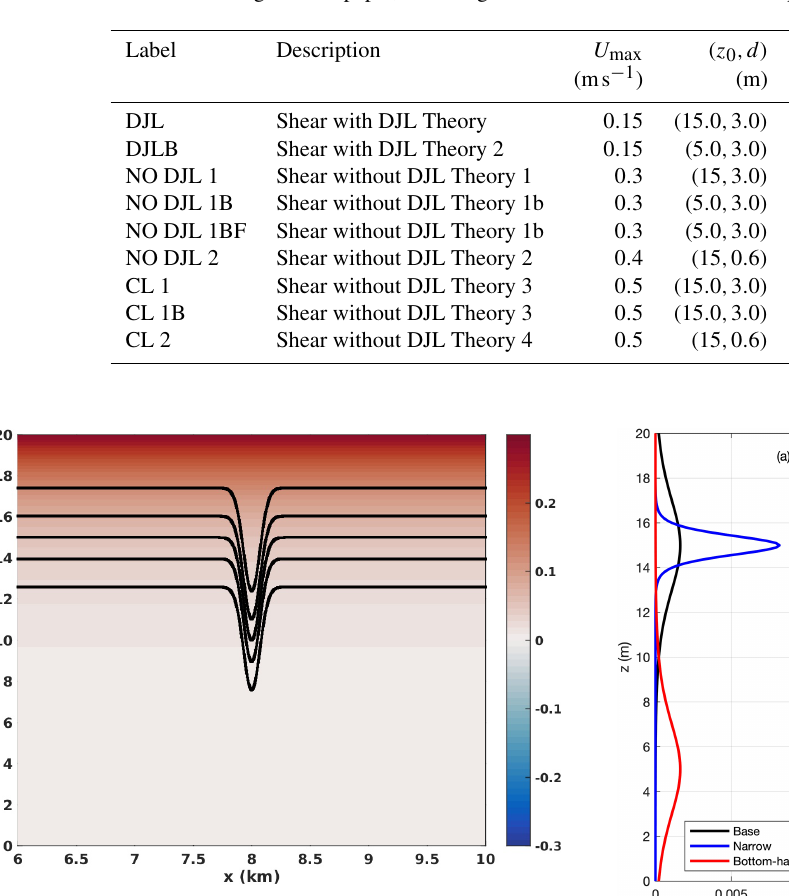
Figure 1. Typical initial conditions. Horizontal component of ve- locity (ms − 1 ) shaded (case NO DJL 1 shown as a representative sample), five isopycnals in black.